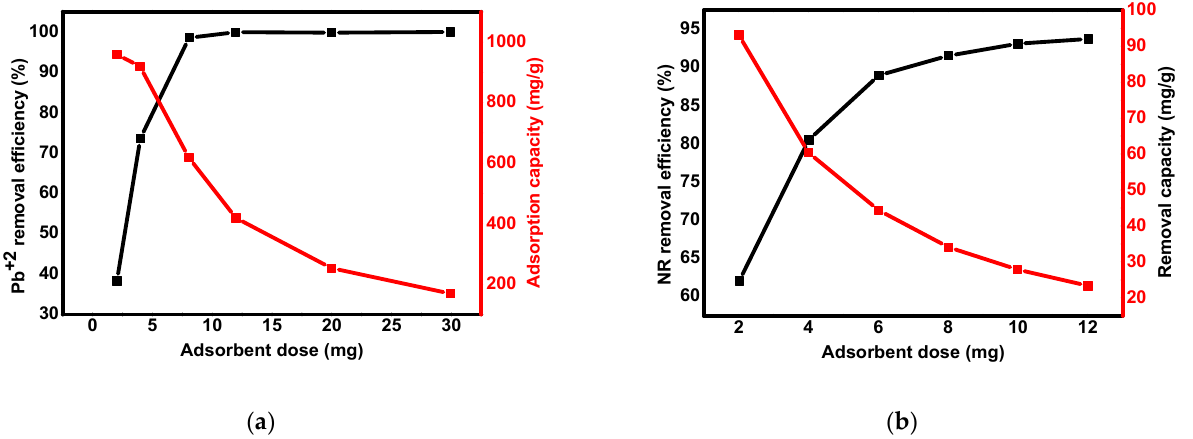
Figure 5. The effect of adsorbent dose on Pb 2+ ions ( a ) and NR dye ( b ) adsorption over MnFe 2 O 4 /GO nanocomposite.